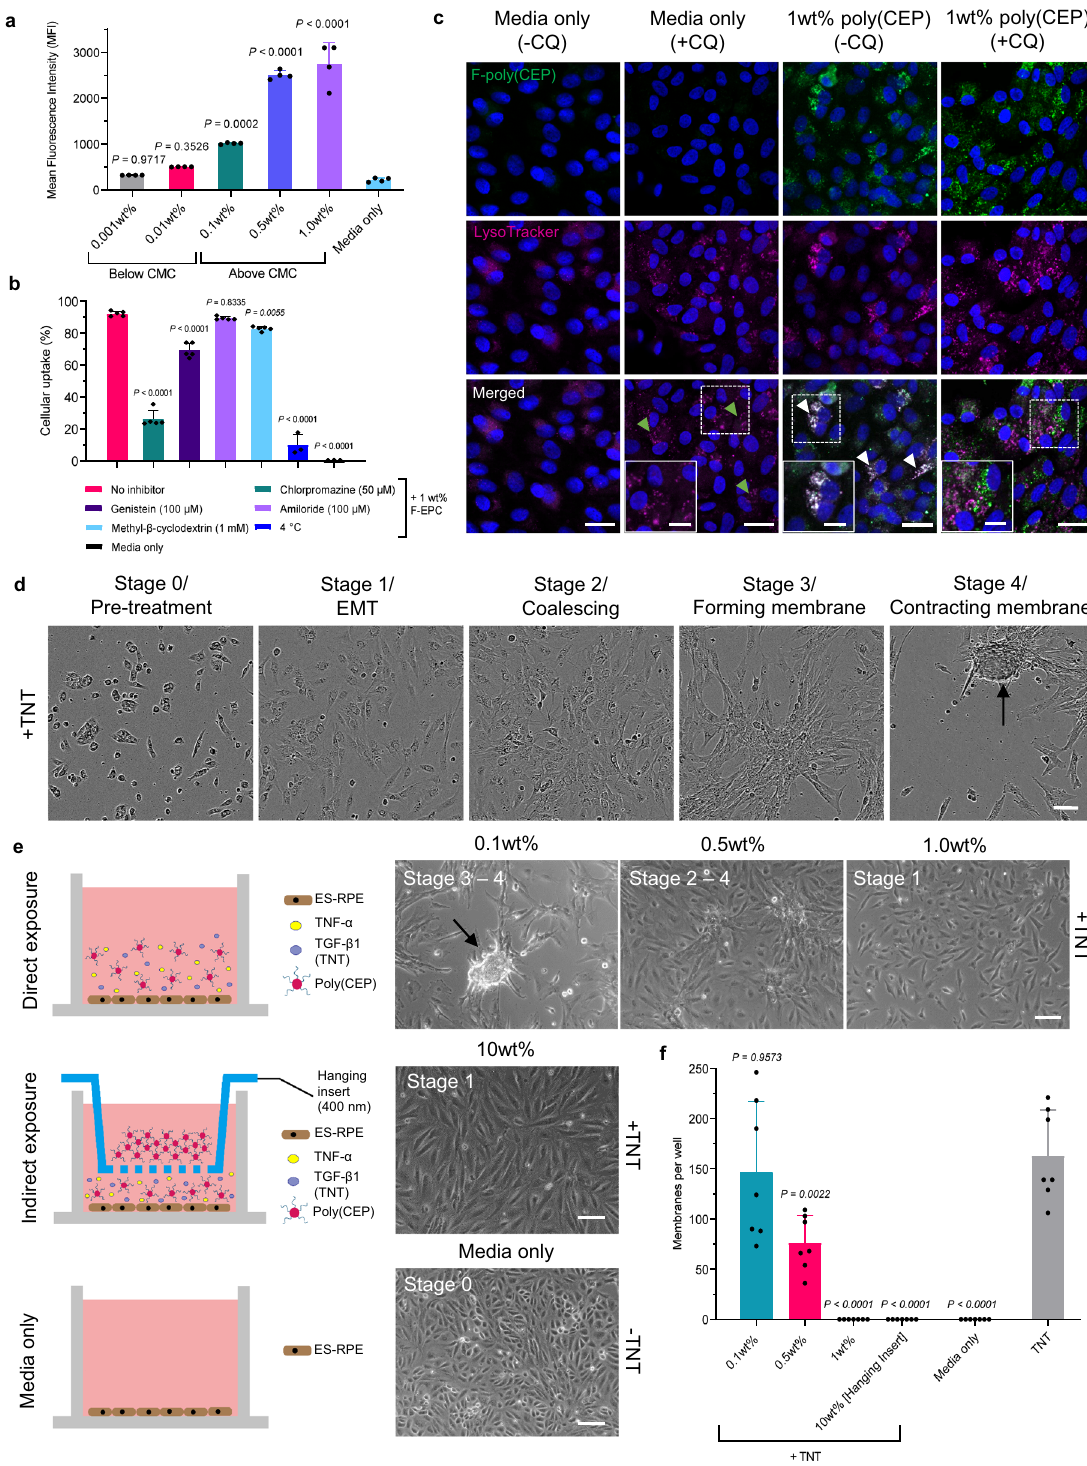
membrane formation. Partial inhibition of membrane forma- tion occurred at 0.5 wt% (76.14 ± 27.41 membranes, P = 0.0022) and was completely inhibited at 1 wt% poly(CEP) + TNT (Fig. 2f and Supplementary Movie 3). This was consistent with previous fi ndings showing that maximum internalisation of micelles was observed at 1 wt%, and con fi rmed that the anti- scarring effects were conferred by the micellar form of